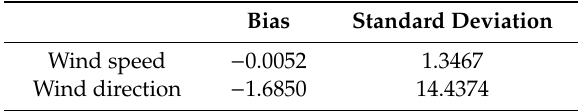
Table 1. ECMWF wind field data and TAO sea surface wind velocity data statistical analysis.